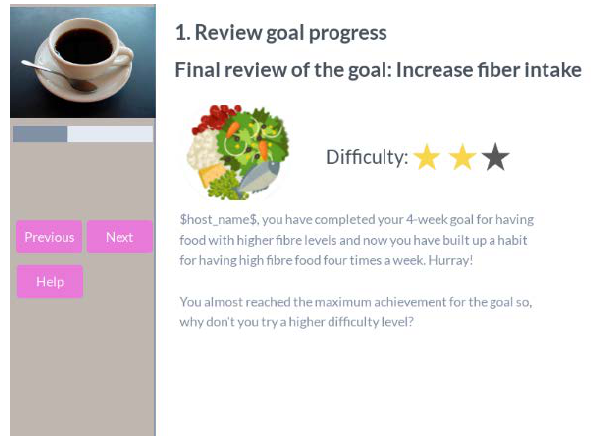
Figure 11. Coffee review progress, goal finish suggestion.